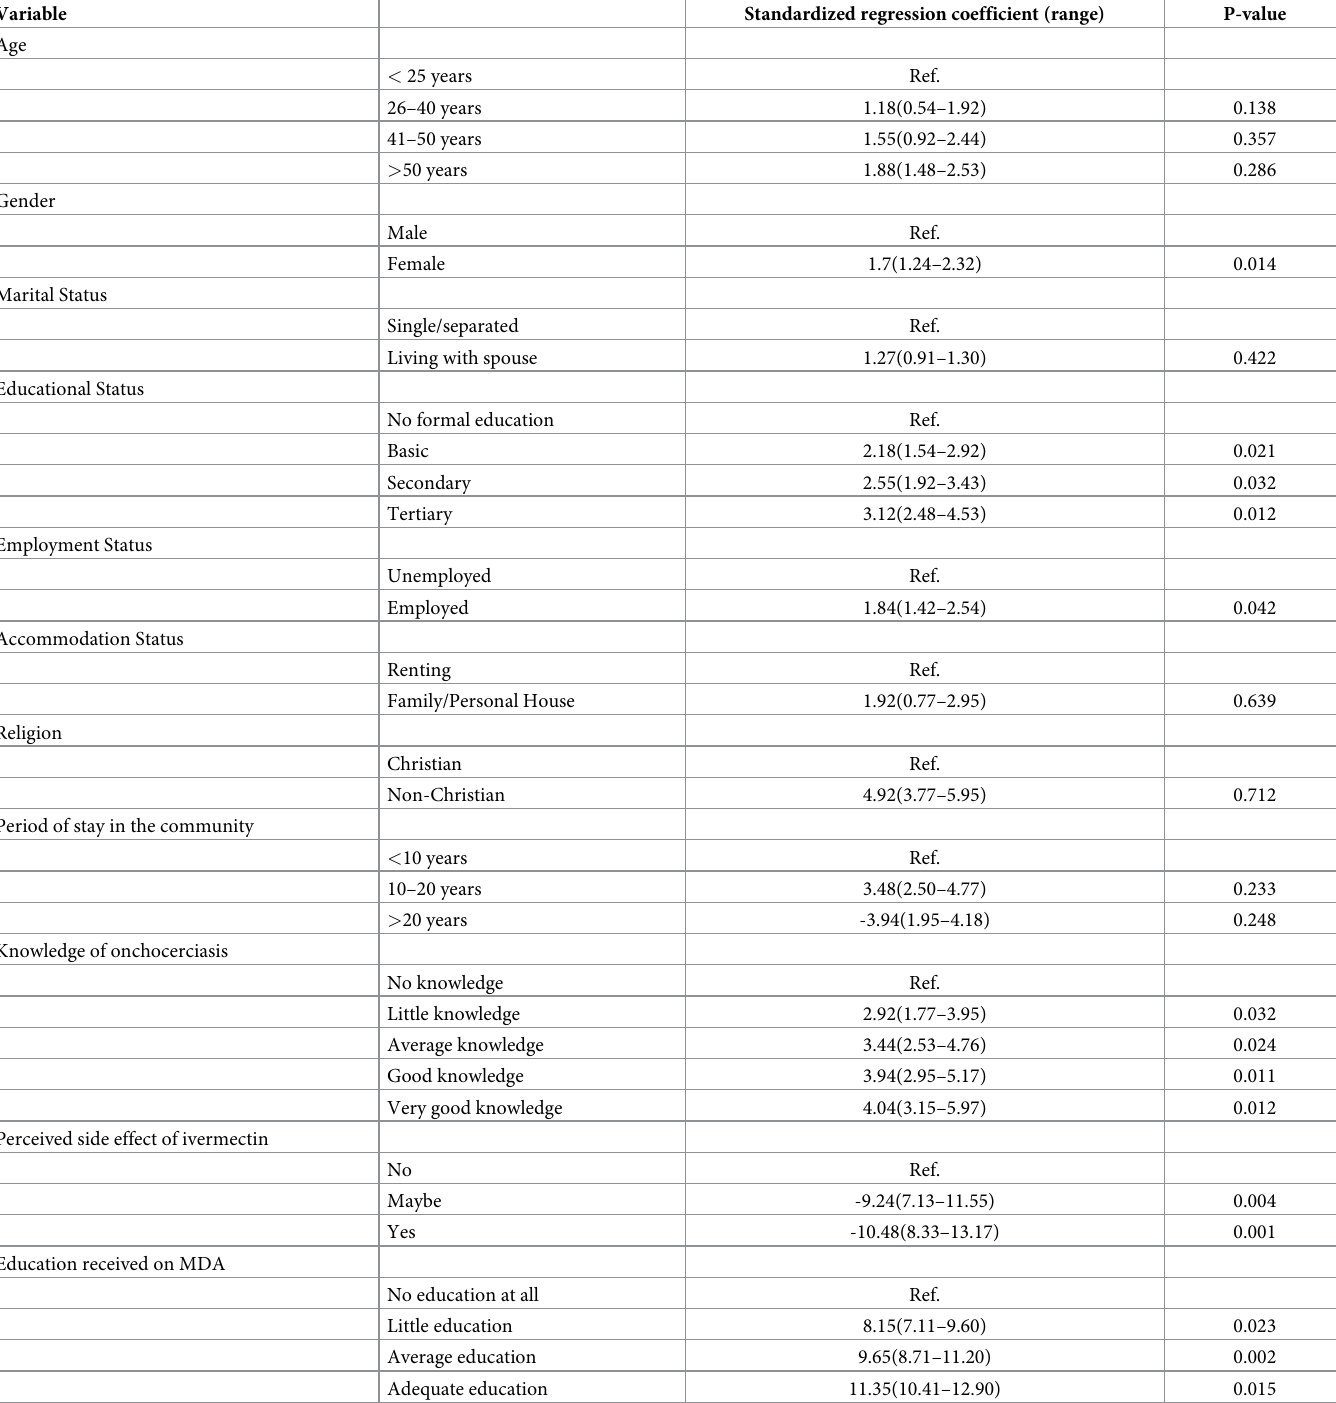
Table 5. Predictors of community acceptability of mass drug administration (n =